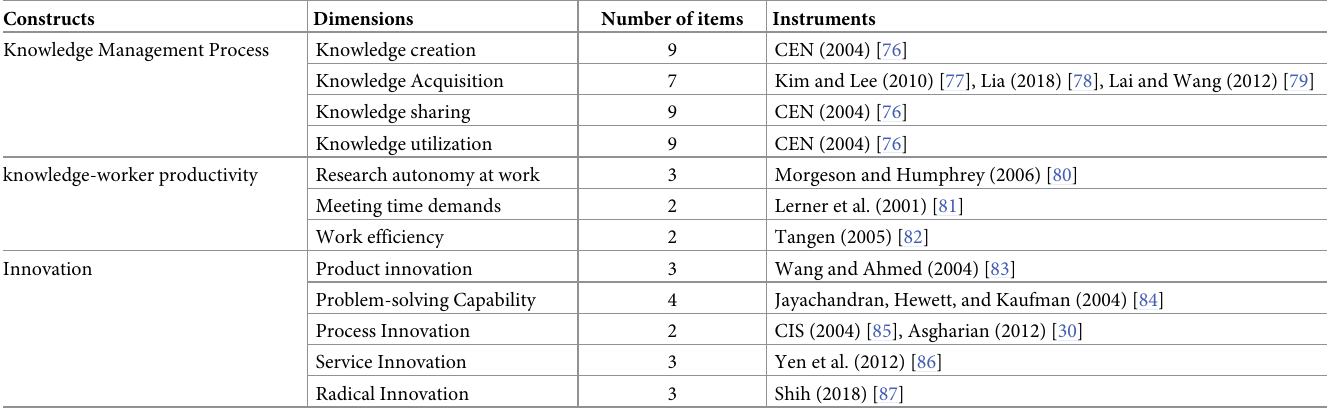
modeling (Smart PLS-SEM 3 version 26 software) to find results. PLS-SEM has the advantage Table 1. Instruments of the